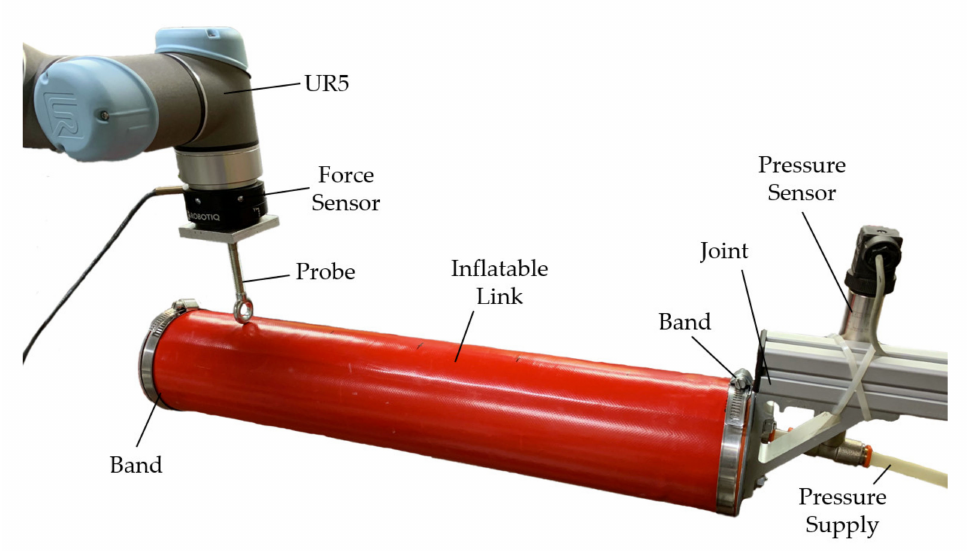
Figure 7. Cantilever beam, experimental set-up.